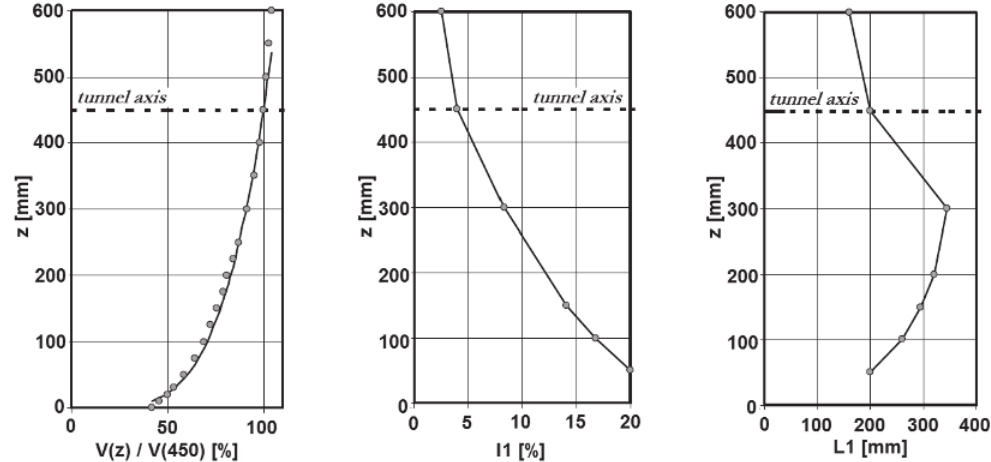
Figure 1 Characteristics of the simulated Wind: (a) Wind profile; (b) turbulence intensity distribution; (c) longitudinal turbulence scale for an exponent p =